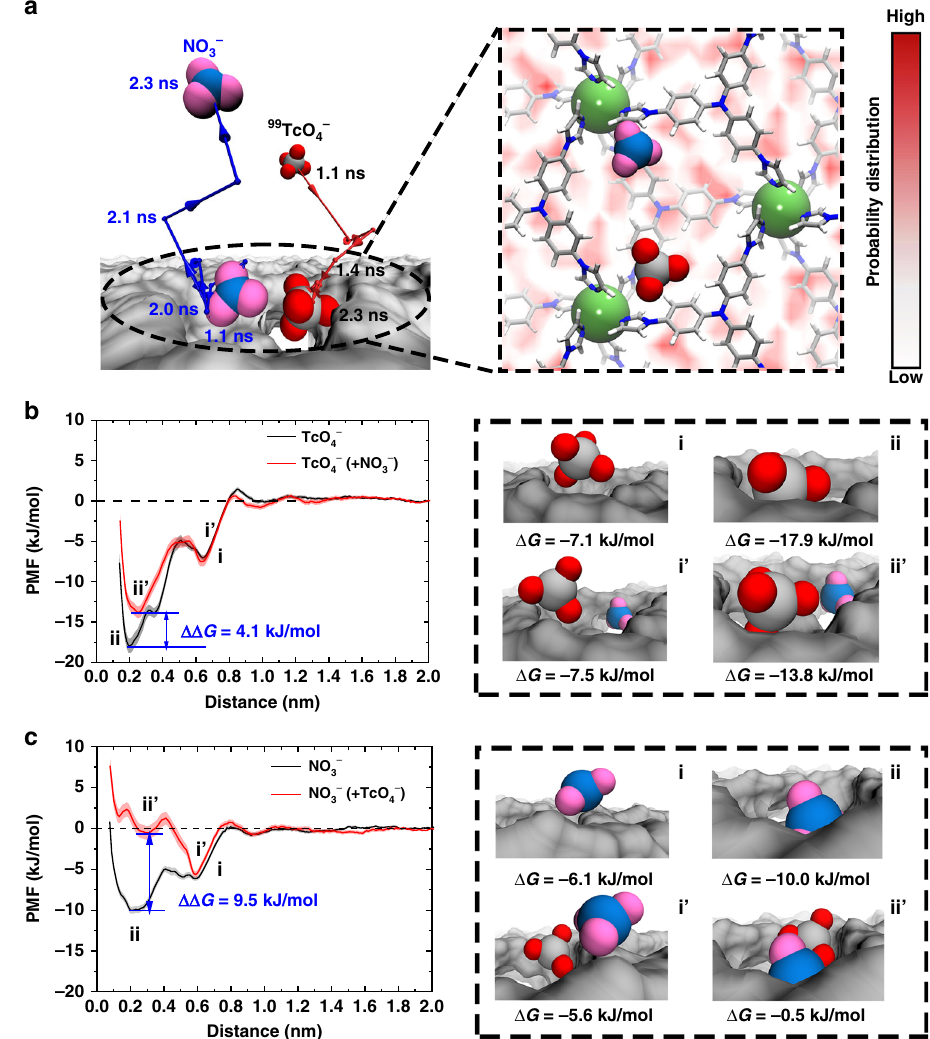
Fig. 6 Binding free energies of 99 TcO 4 − and NO 3 − to their most energetically favorable sites in SCU-103. a A representative anion-exchange process of NO 3 − by TcO 4 − (left). The red and blue lines with an arrow represent the center of mass motion trajectory of TcO 4 − and NO 3 − from 1.1 ns to 2.3 ns. The most important crucial intermediate state during the anion-exchange process is shown when TcO 4 − binds to its fi nal binding site, while NO 3 − dwells at its original binding site (right). The color gradient of the background demonstrates the binding probability distribution of NO 3 − to SCU-103, and ranges from lowest probability (0, white) to highest probability (0.110, red). b and c Binding free energies of TcO 4 − /NO 3 − alone to its fi nal binding site (black curves), and the binding free energies of the two anions at the crucial intermediate state (red curves). Snapshots highlighted by the black dashed lines represent the typical binding con fi gurations of TcO 4 − /NO 3 − anions to SCU-103 corresponding to the energy minima in the free energy curves. The shadows in b and c represent the predictive error of the binding free energy pro fi